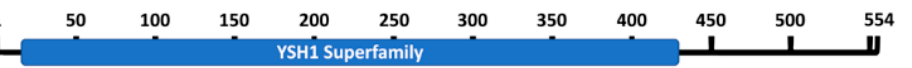
Figure 2. Schematic of Fd PsoR protein domains. The full-length PsoR sequence from Fremyella diplosiphon was analyzed using BLASTp [50]. Amino acids 19–430 of Fd PsoR have sequence similarity to the Ysh1 superfamily of proteins (shown as a blue-labeled box).